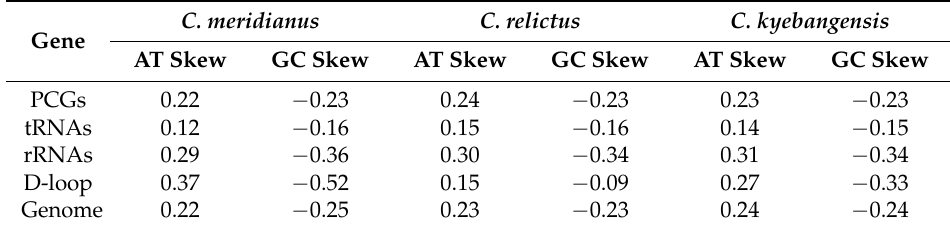
Table 3. AT skew and GC skew of C. meridianus , C. relictus and C. kyebangensis